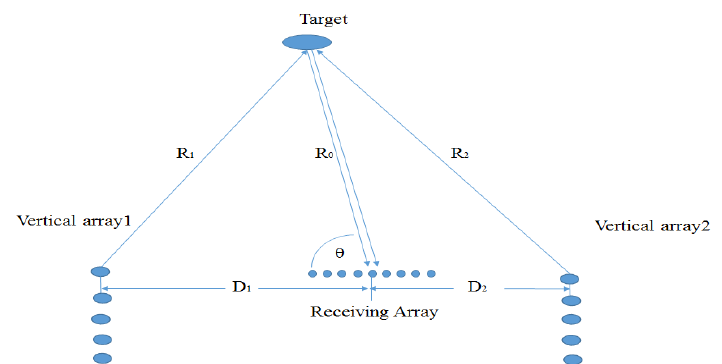
Figure 1. The array configurations for exploiting spatial